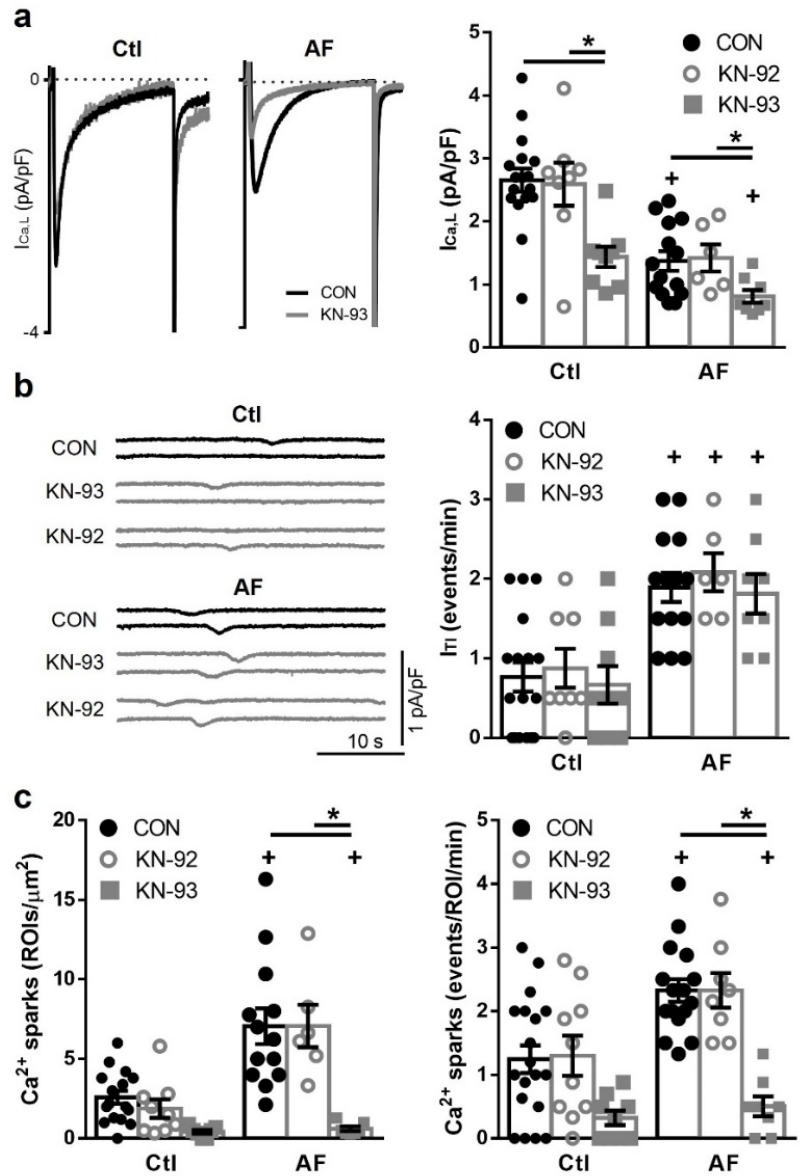
Figure 2. Effects of Ca 2+ /Calmodulin-dependent protein kinase II (CaMKII) inhibition on I Ca,L , I TI and Ca 2+ sparks. ( a ) ( left ): Representative I Ca,L recordings in myocytes from a patient in sinus rhythm (Ctl) and a patient with atrial fibrillation (AF) before (CON, black trace) and after exposure to a selective CaMKII inhibitor (KN-93, 1 µ M, grey trace). ( right ): Average effects of KN-92 (1 µ M, the inactive CaMKII inhibitor) and KN-93 in Ctl and AF patients. ( b ) ( left ): Representative recordings of spontaneous I TI before and after exposure to KN-92 and KN-93 in myocytes from in Ctl and AF patients. ( right ): Average effects of KN-92 and KN-93 on the spontaneous I TI frequency in AF and Ctl myocytes. ( c ) Average effects of KN-92 and KN-93 on Ca 2+ sparks density ( left ) and frequency ( right ) before and after exposure to KN-92 and KN-93. Significant differences between treatments are indicated with * and between groups with +.